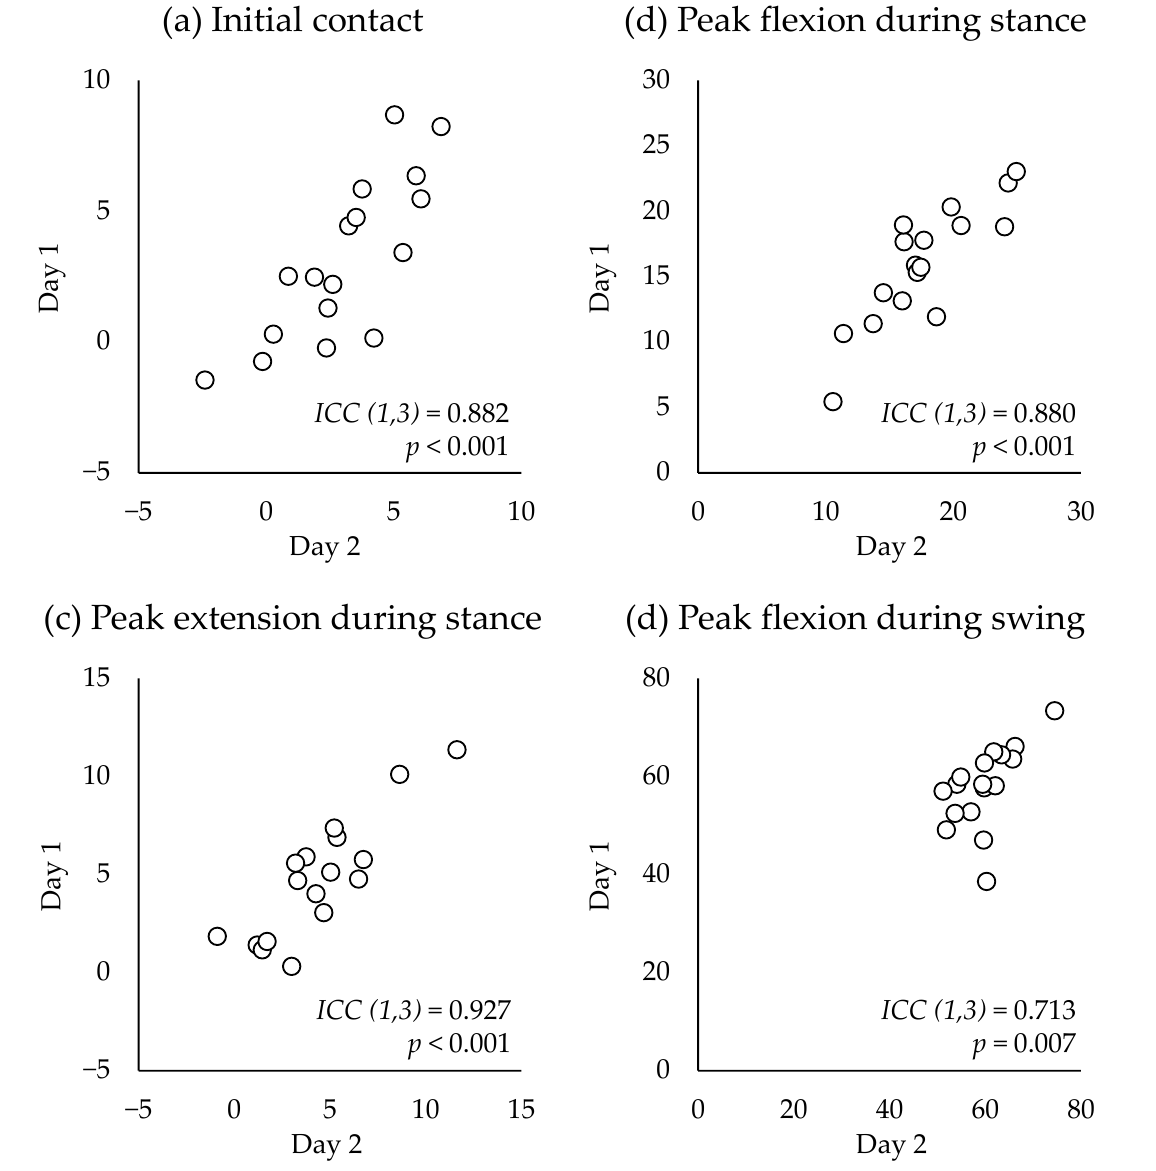
Figure 8. Correlations of the discrete values between Day 1 and Day 2 (1 week later) of wearable goniometer